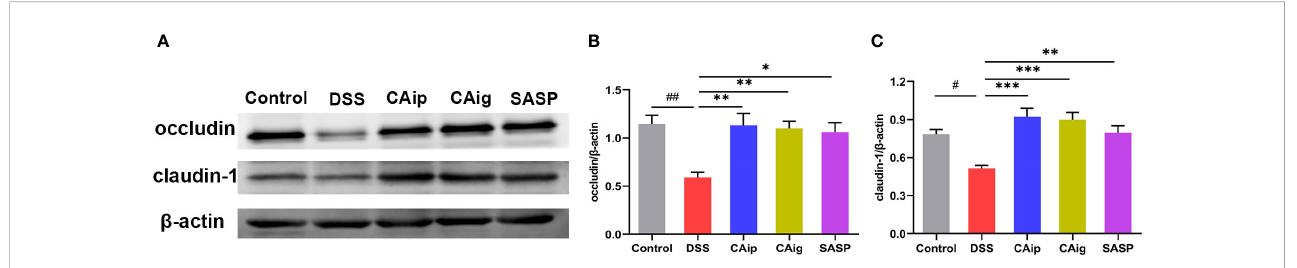
FIGURE 4 CA protected intestinal epithelial barrier by enhancing TJs proteins. Representative western blotting images of occludin and claudin-1 (A) , and the relative protein expressions were normalized to b -actin (B, C) . Data are shown as the mean ± SEM (n = 5). # P < 0.05, ## P < 0.01 vs. Control group, * P < 0.05, ** P < 0.01, *** P < 0.001 vs. DSS